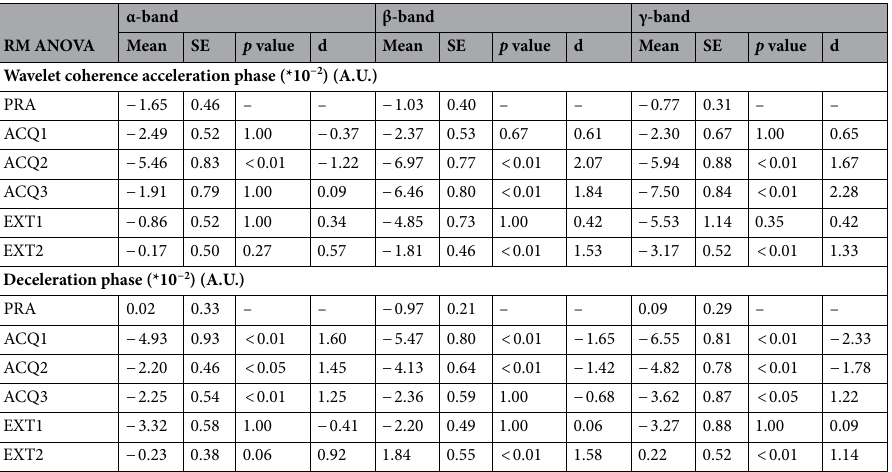
Table 2. Summary data and post hoc analysis of a one-way ANOVA. The post hoc analysis of a one-way ANOVA was used between the acquisition periods and the practice period, and between the extinction periods and the third block of the acquisition period. Mean: Mean value. SE: Standard error. p < 0.05: Statistically significant after Holm-Bonferroni correction. d: effect size of post hoc analysis. PRC: practice phase. ACQ1–3: 1st, 2nd, and 3rd blocks of the acquisition phase. EXT1–2: 1st and 2nd blocks of the extinction phase.